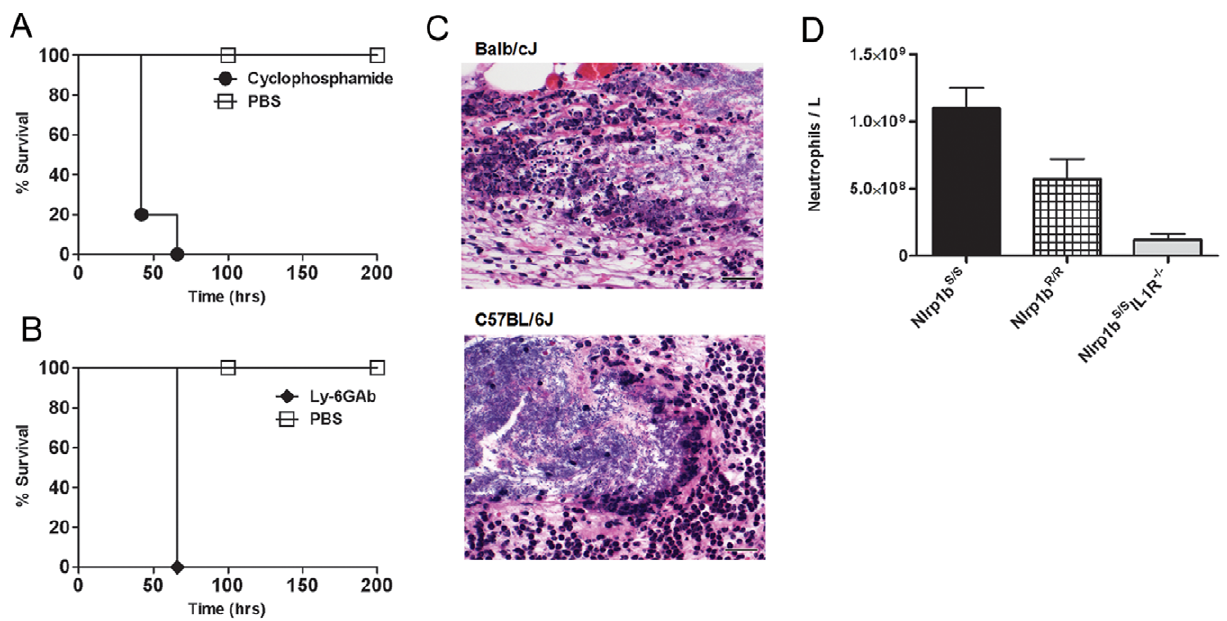
Figure 6. Neutrophils protect against B.anthracis infection. Balb/cJ mice were treated with cyclophosphamide (A) or a neutrophil-depleting antibody (B) prior to SC challenge with the dose of 1 6 10 7 spores (to which they are normally resistant) and compared to PBS-treated controls receiving the same spore challenge. P-values for comparison of the two curves in each panel are , 0.003. (C) H&E stain of infected skin sections taken 8 h after infection of Balb/cJ and C57BL/6J mice. Left panels represent images taken at 50 6 (scale bar=200 micron); right panels are higher magnification (400 6 ) detail of a region from left panels showing the boundaries of bacteria and neutrophils (scale bar=25 microns). (D) C57BL/6NTac Nlrp1b S/S and C57BL/6NTac Nlrp1b R/R and Nlrp1b S/S IL1R 2 / 2 mice were infected with 6 6 10 7 spores (SC) and cell blood counts analyzed after 4 h. The neutrophil counts shown are for n=4 mice/group. Baseline neutrophil counts for uninfected mice were an average of 4.45 6 10 8 /ml. P-values comparing any two groups are ,